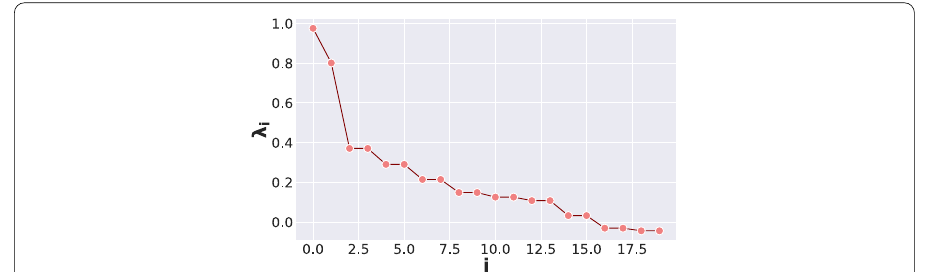
Fig. 9 The large spectral gap after the second eigenvalue of the Koopman operator approximated by graphKKE indicates that the cholera infection dataset can be divided into two metastable